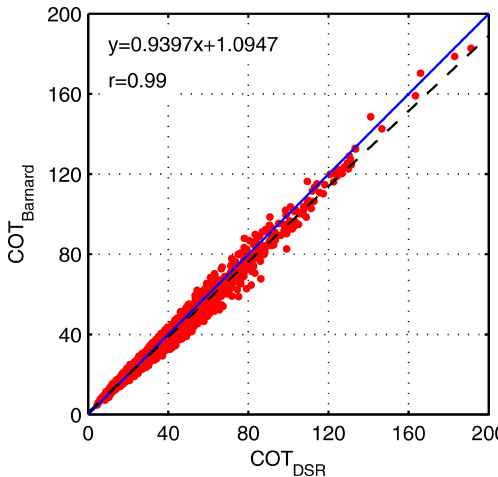
Figure 8. Correlation between COT values retrieved from DSR (COT DSR ) and from the equation presented in Barnard and Long (2004) (COT Barnard ) for St–As in